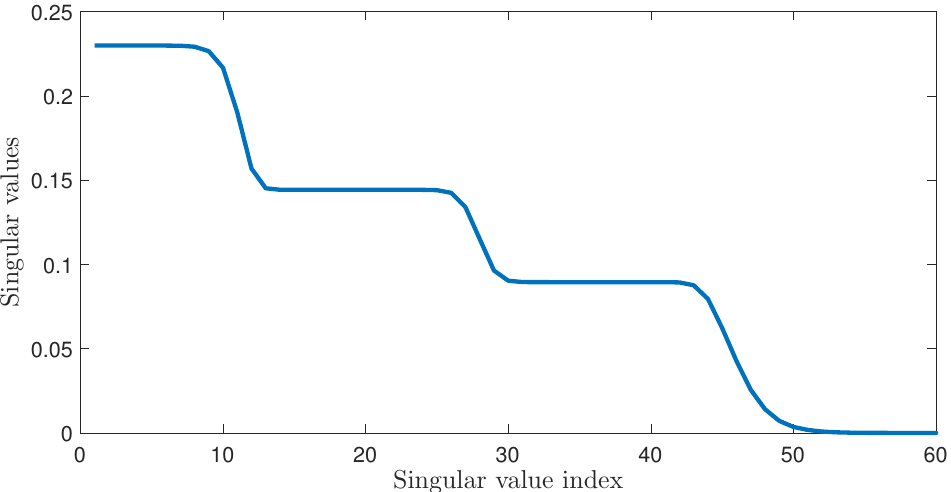
Figure 7. Singular values behaviour of A f for M = 3 frequencies The configuration parameters are a = 30 λ min , X o = 45 λ min , z (cid:48) = 125 λ min , λ max = 4 λ min and λ min = 1/4m. The foreseen values for the σ n on each step are 0.2298, 0.1442 and 0.0894, while for the knees are 10, 27 and 43. They agree with the values indicated in